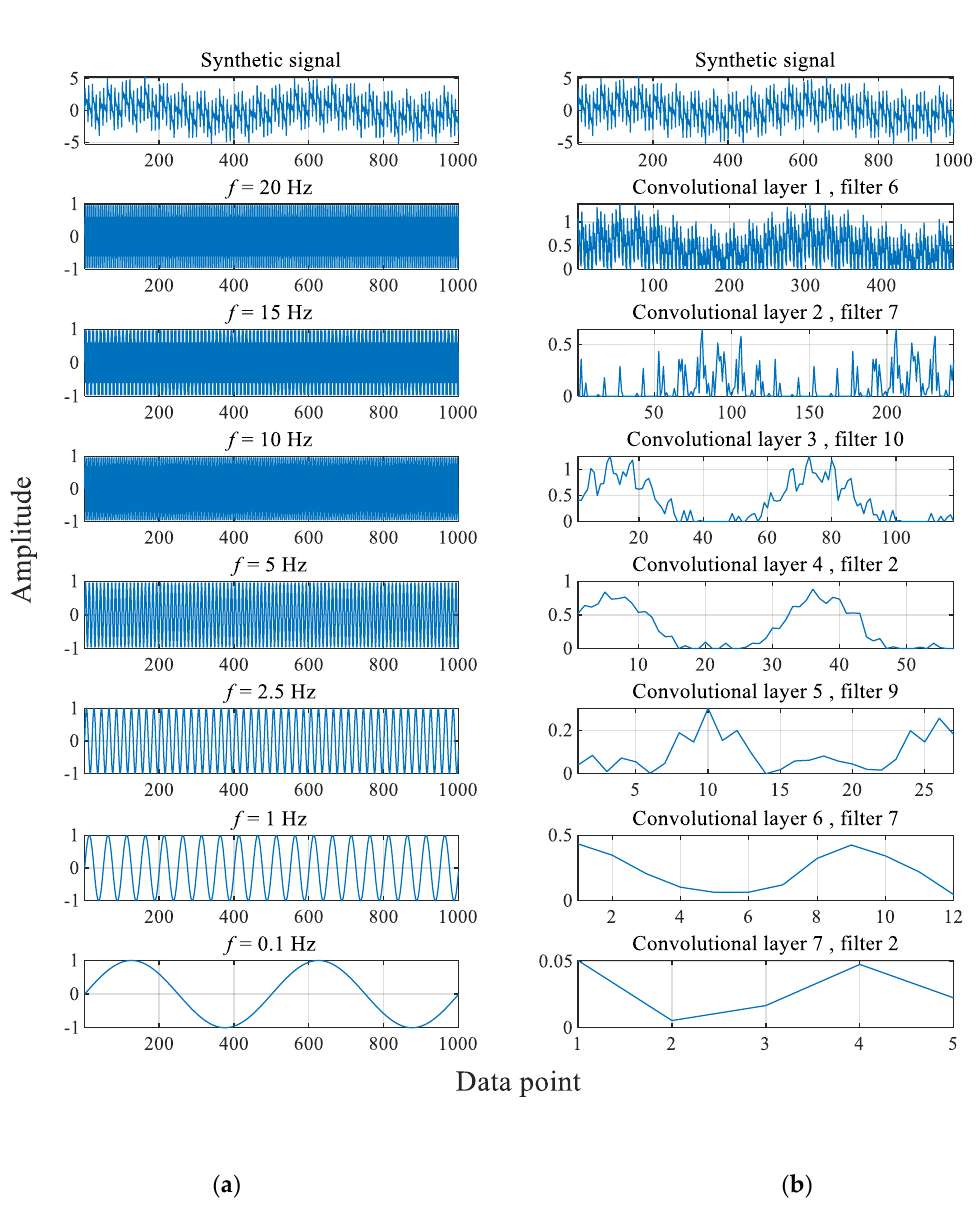
Figure 15. Comparison of synthetic signal components and extracted features: ( a ) Synthetic signal and its simple harmonic components; ( b ) features extracted from different convolutional layers.